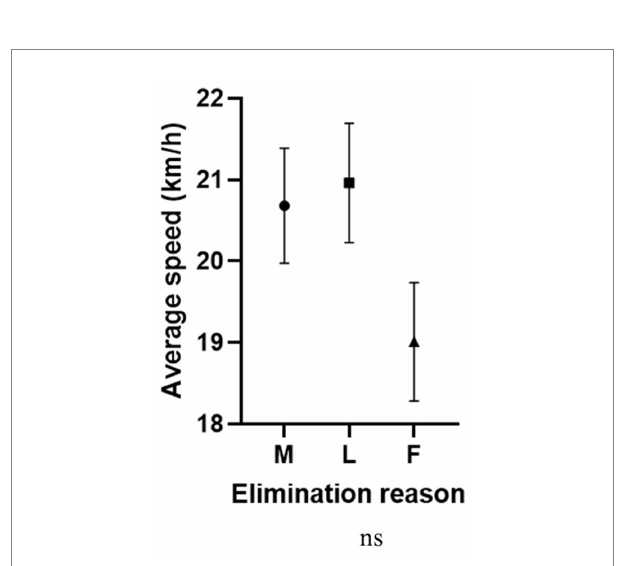
FIGURE 5 Association between average speed (km/h) and elimination reason (ns). M, metabolic eliminations; L, lameness eliminations; F,